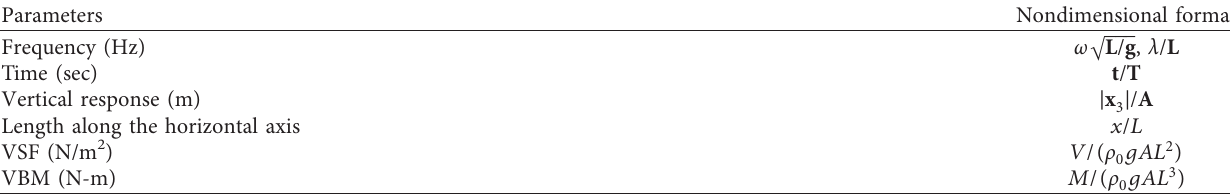
Table 2: Nondimensional dynamic response parameters.